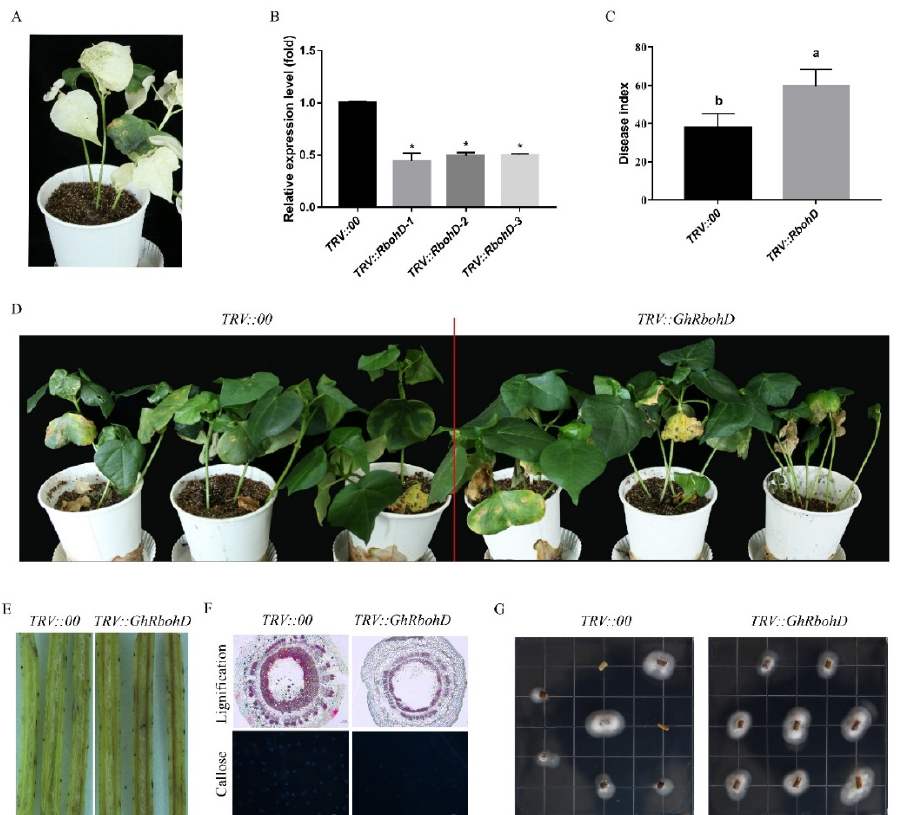
Figure 3. The resistance of cotton to Verticillium dahliae decreased after GhRbohD silencing. ( A ) TRV::PDS as the positive control for silencing efficiency. Albino phenotype appeared at 12 days after infection. ( B ) The expression level of GhRbohD in silenced plants and control plants. ( C ) Assessment of DI for TRV::00 plants and TRV::RbohD plants at 20 dpi. ( D ) The incidence of disease in control and silencing plants. ( E ) Vascular browning in cotton stem after infection. ( F ) The xylem